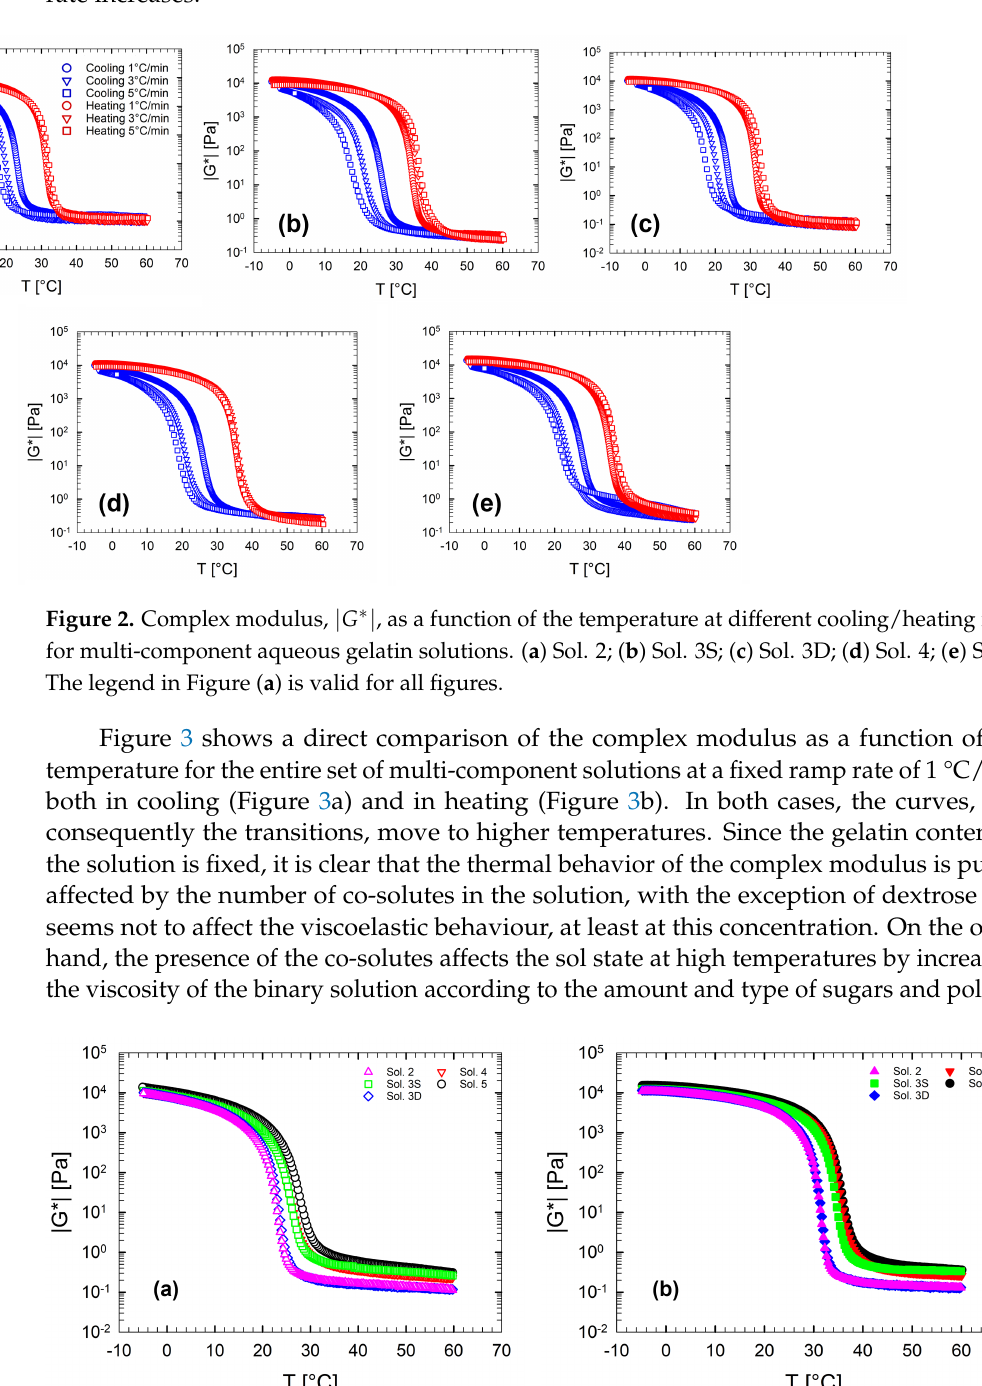
Figure 3. Complex modulus, aqueous gelatin solutions: ( a ) Cooling ramps and ( b ) heating ramps.